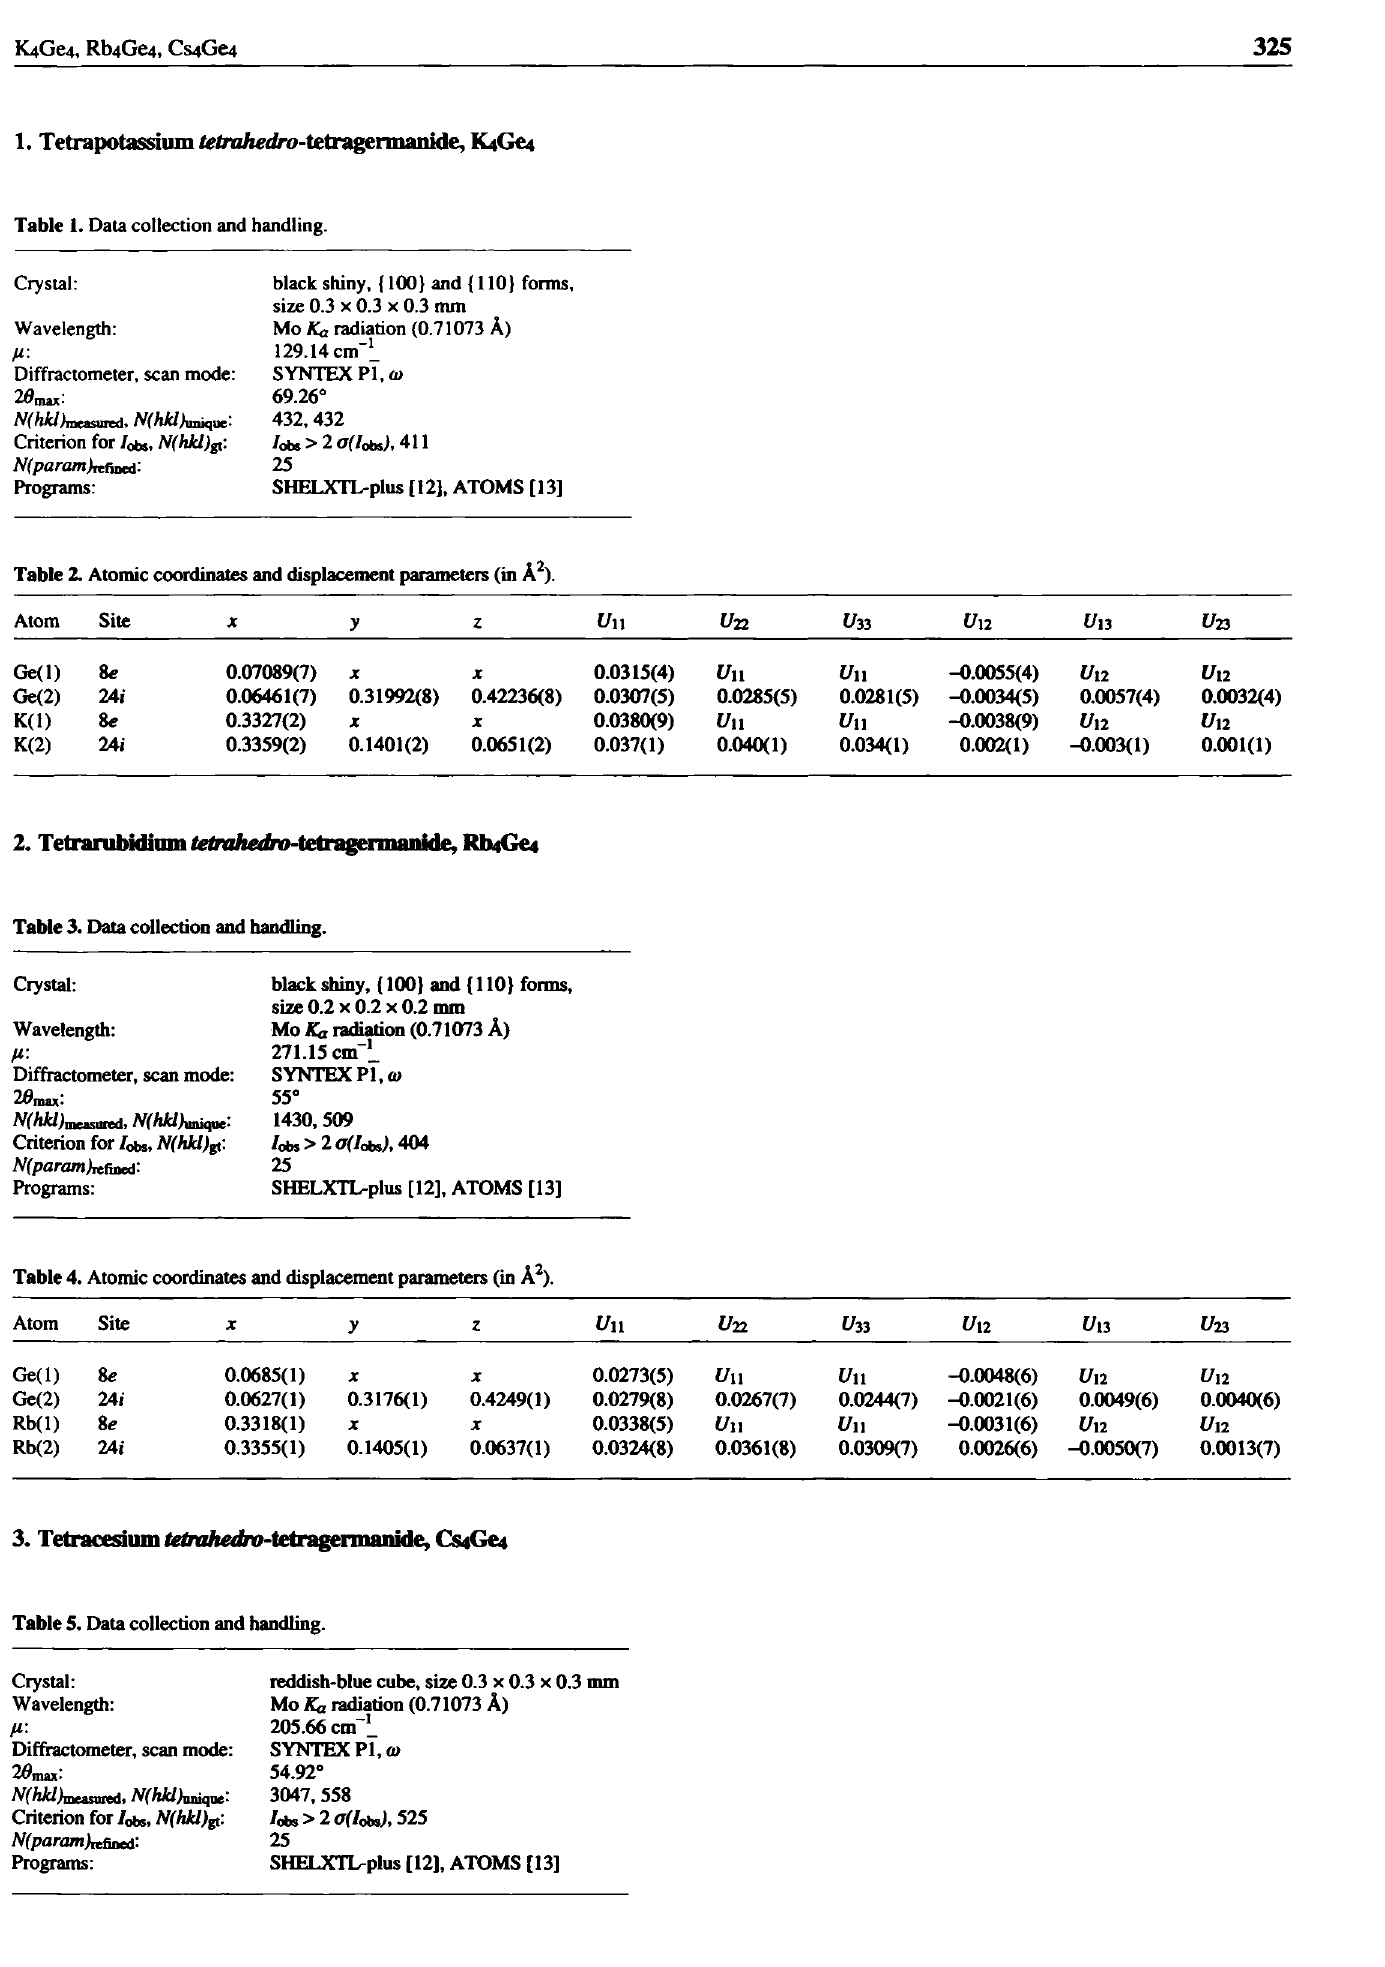
Table 1. Data collection and handling.